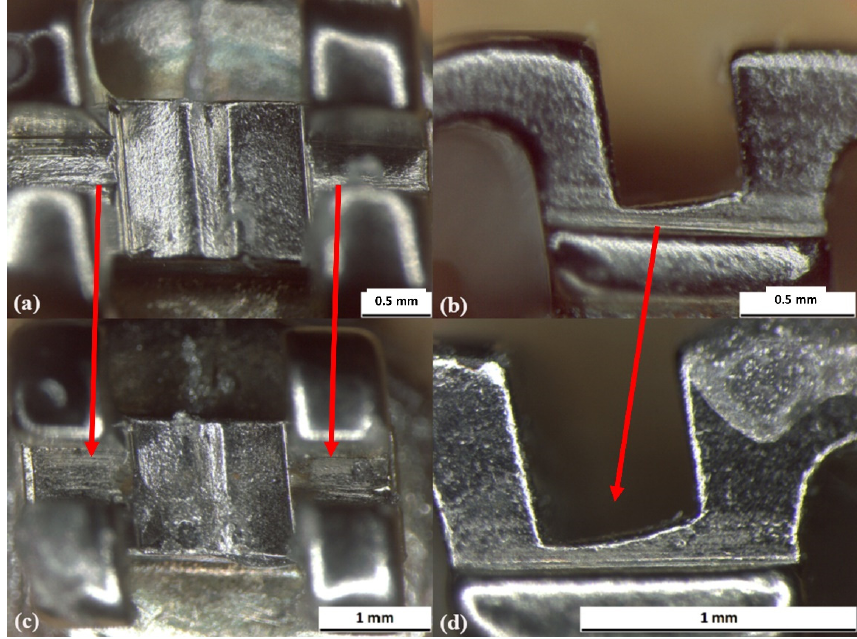
Figure 10. LP bracket (American Orthodontics) in top and side view: ( a , b ) before the test; ( c , d ) after the test.